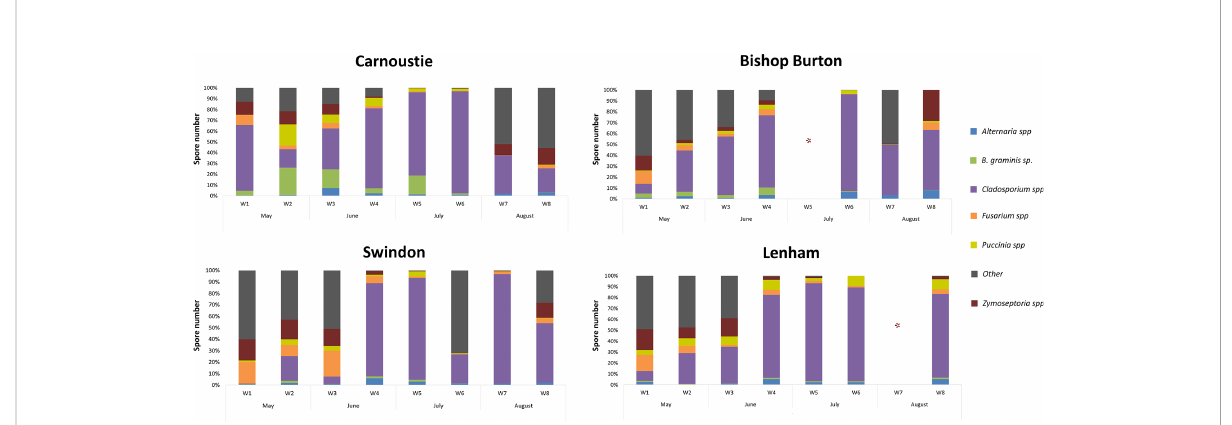
FIGURE 3 Weekly percentages of spores from the six major pathogens recognized and detected with the microscopic analysis at the four sites. Asterisk (*) denotes missing data in week 5 from the Bishop Burton fi eld site and at week 7 at the Lenham fi eld site due to mechanical failure of the spore trap.